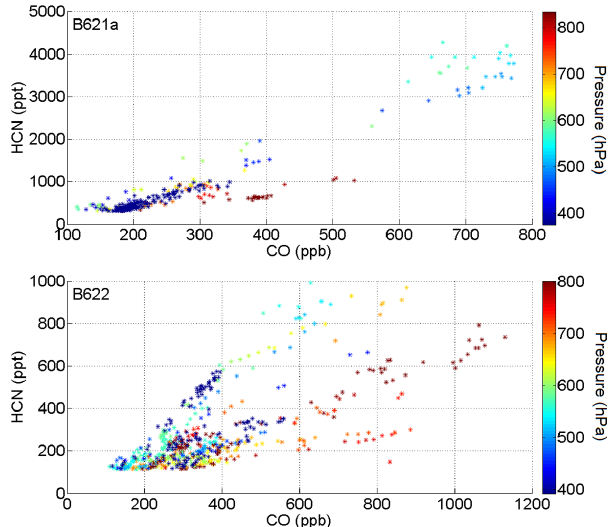
Figure 5. Scatter plot of the HCN and the CO as function of the pressure for the flights B621a (at the top) and B622 (at the